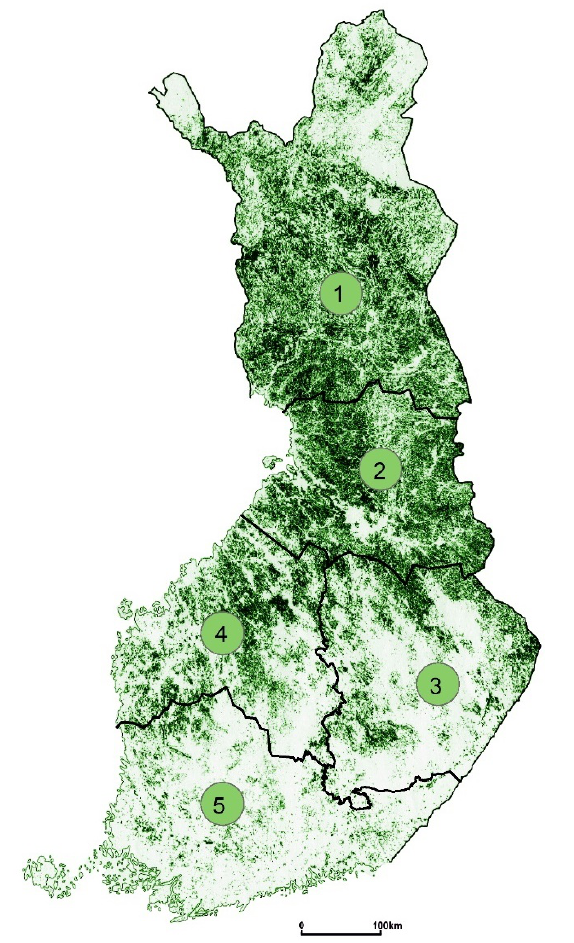
Figure 1. Peatland distribution in Finland (green colour) and the outlines of the five regions used in this study. 1 = Lapland, 2 = northern Ostrobothnia, 3 = eastern Finland, 4 = western Finland, 5 = southern